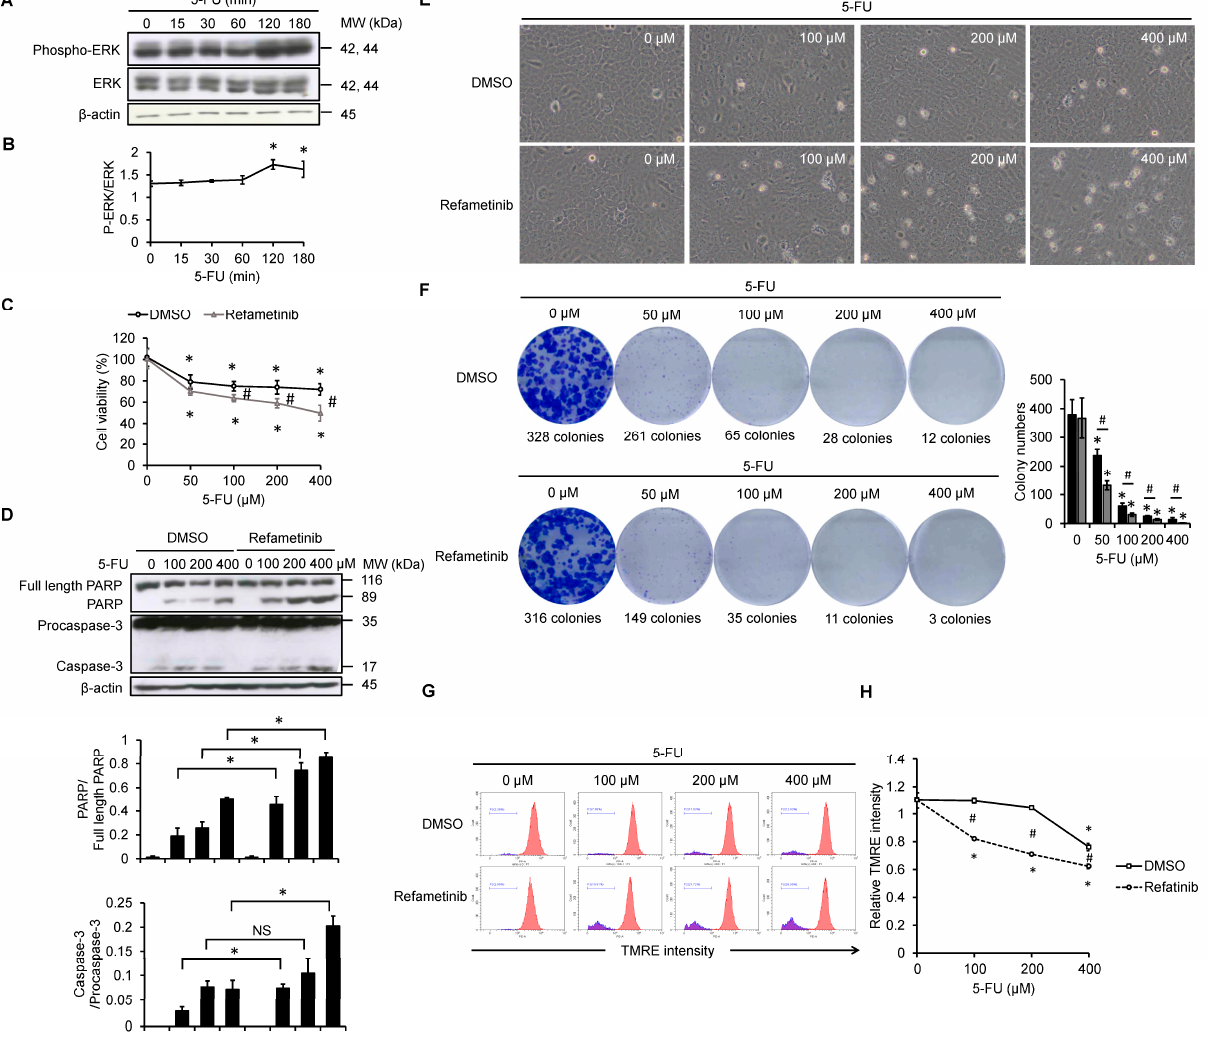
Figure 2. Refametinib sensitizes SCC4 cells to 5-FU treatment for suppressing cell proliferation and promoting apoptosis. ( A , B ) The cells were treated with 5-FU (50 µM) for the indicated time intervals. The ( A ) Western blot analysis and ( B ) relative densitometric graph showing the phosphorylation of ERK1/2. ( C – H ) The cells were pre-incubated with Refametinib (Re; 50 nM) for 1 h and then treated with increasing concentrations of 5-FU (50, 100, 200, and 400 µM) for 24 h. ( C ) The cell viability was measured using MTS/PMS assay. The ( D ) Western blot analysis showing the protein expression of PARP, cleaved PARP, pro-caspase-3, and caspase-3. The relative densitometric graphs showing PARP and caspase-3 cleavage. ( E ) The cell density was observed under a light microscope (10×). ( F ) Representative images of colony formation assay and their quantitative analysis. ( G , H ) Mitochon- drial membrane potential was measured through fl ow cytometry using TMRE. * p < 0.05, as com- pared to the control. # p < 0.05, 5-FU alone vs. 5-FU + Refametinib. All experiments were inde- pendently performed at least three times.